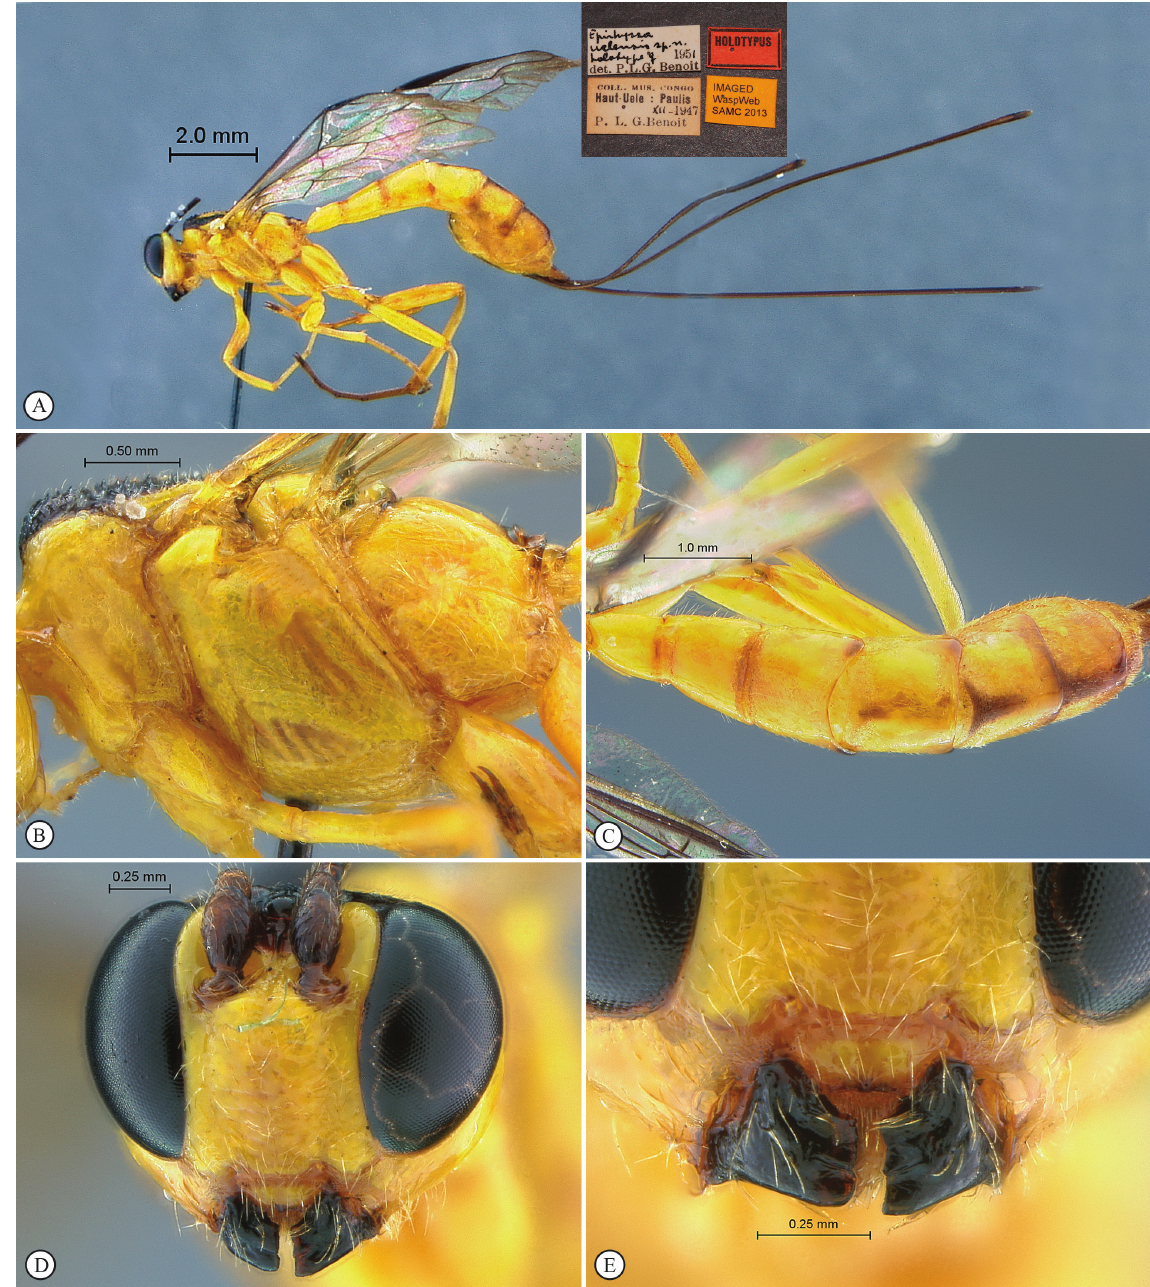
Fig. 10. Epirhyssa uelensis Benoit, 1951, holotype, ♀. A . Habitus, lateral view (inset: data labels). B . Mesosoma, lateral view. C . Metasoma, dorsal view. D . Head, anterior view. E . Mandibles, anterior